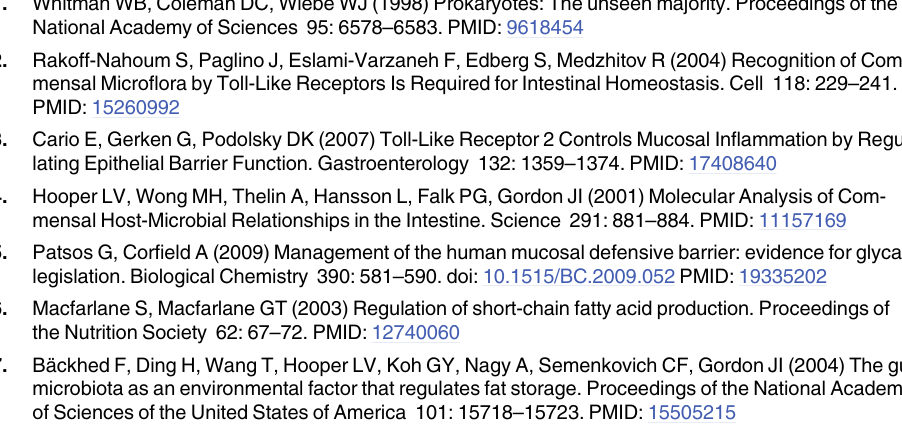
L_GF (145 genes) PI -L PI